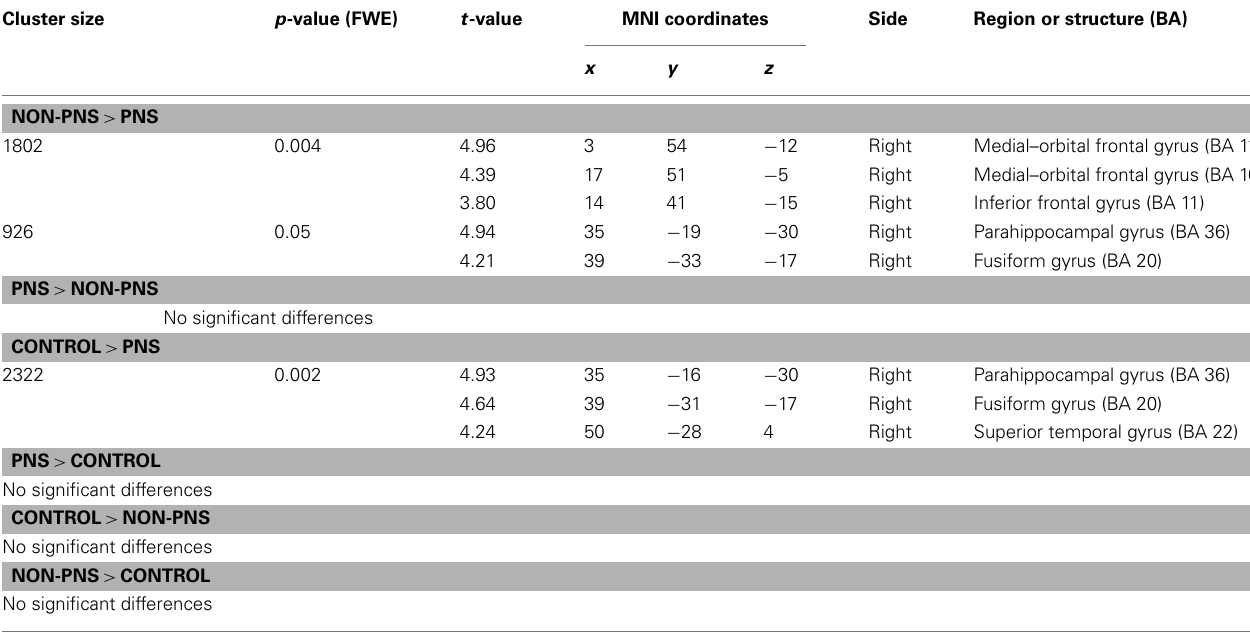
Table 5 | Gray matter differences among PNS patients, non-PNS patients, and healthy controls using voxel-based morphometry. Cluster